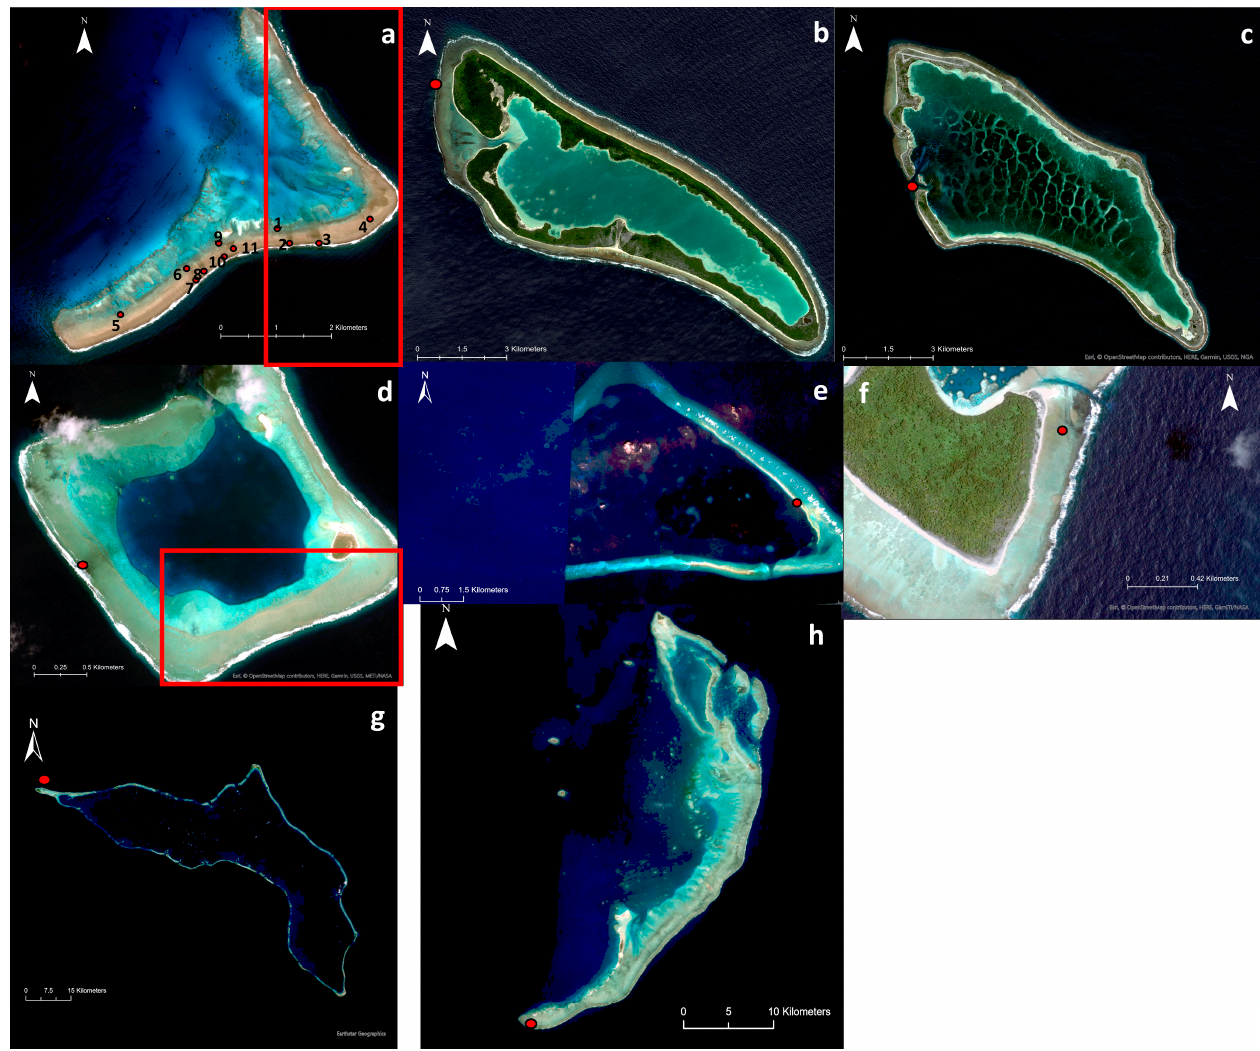
Figure 2. Vision-1 imagery from ( a ) Kenn reef, ( b ) Nikumamoro reef and ( c ) Kanton reef. Google Earth imagery from ( d ) Rose reef, ( e ) Kingman reef, ( f ) Caroline reef, ( g ) Kwajalein reef and ( h ) St Brandon reef (Google Earth Pro, viewed 21 May 2021). The red dots show the locations of the shipwrecks in each reef. For the Kenn and Rose reefs, the areas inside the red rectangle represent the part of the image used for labelling and later for evaluation. The rest of the images were used only for evaluation purposes.